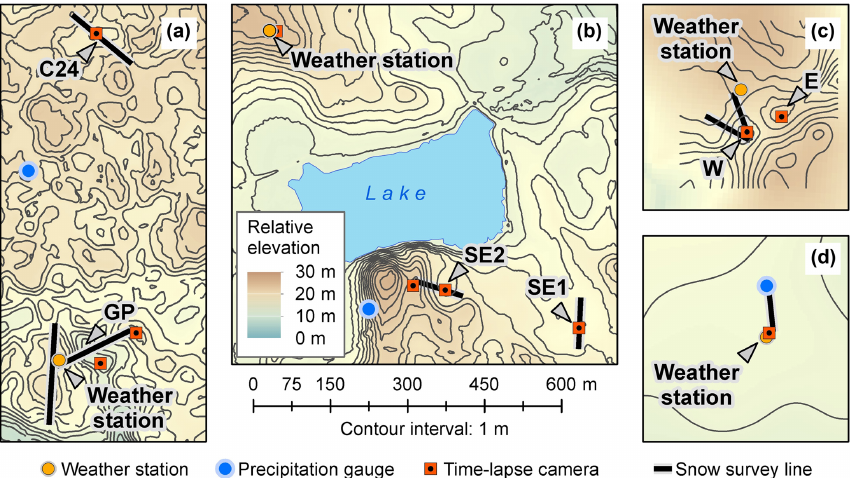
Figure 2. Instrument set-up at the study sites: (a) Spyhill, (b) Stauffer, (c) Triple G, and (d) Fort Macleod. Contour interval is 1m.